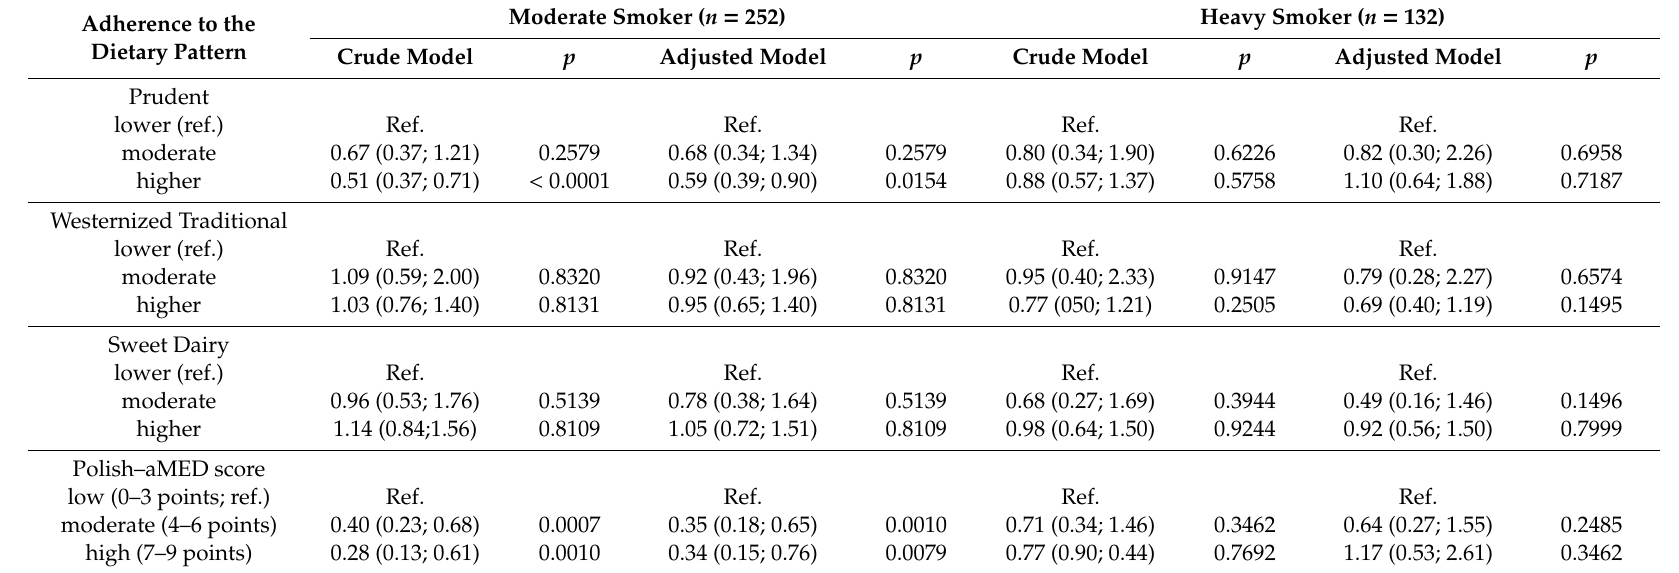
Table 5. Odds ratios (95% confidence intervals) of lung cancer risk by adherence to the dietary patterns in smokers. Adherence to